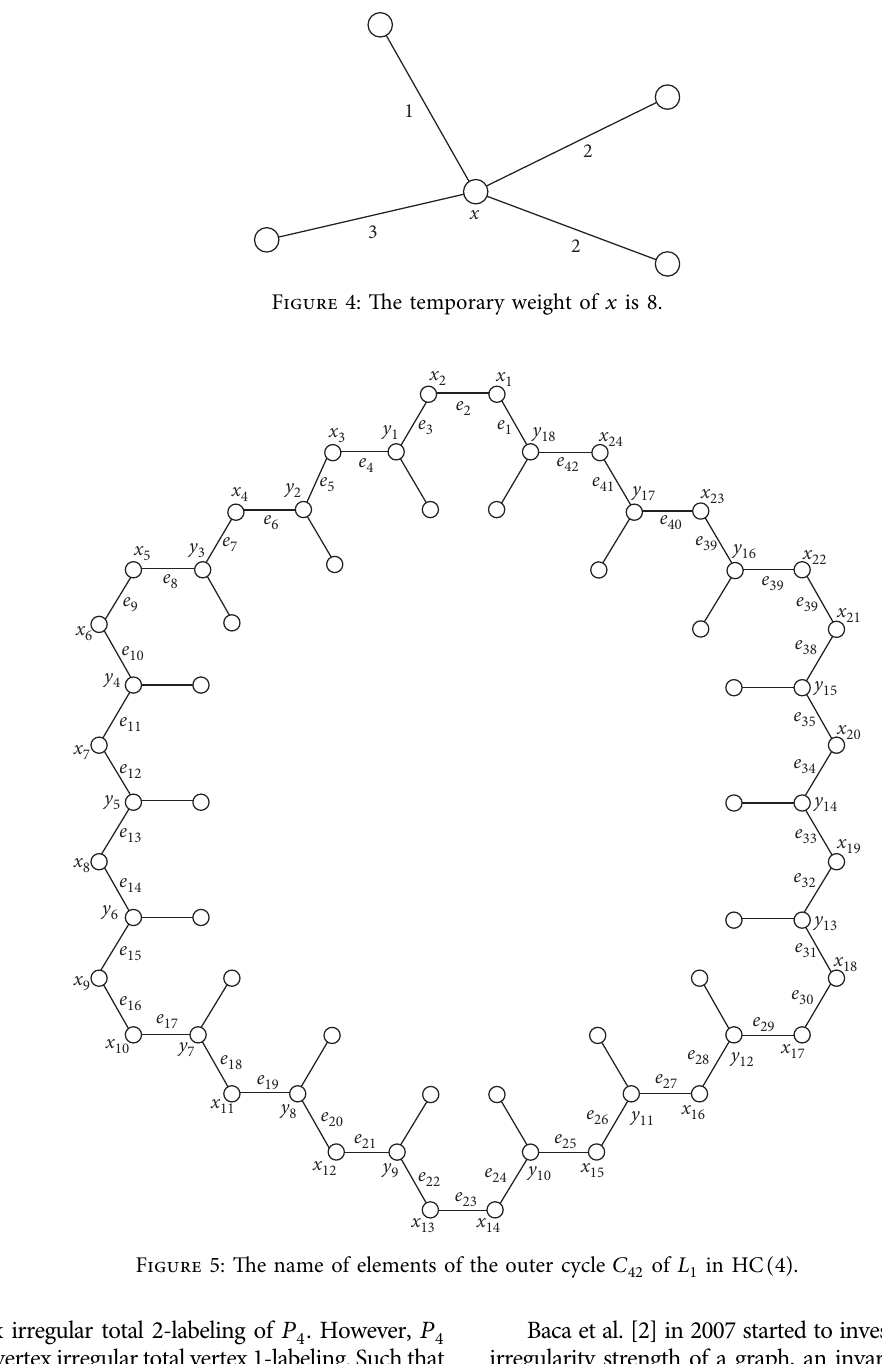
of L in HC ( 4 ) 42 1